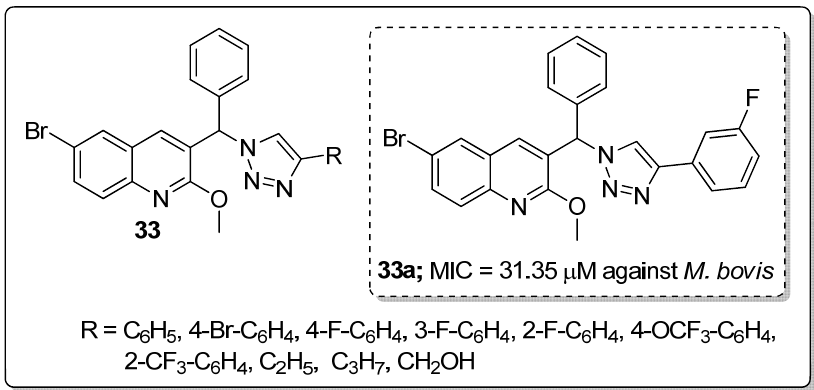
Figure 38. The antitubercular activity of the most active quinoline-triazole hybrid 33a .